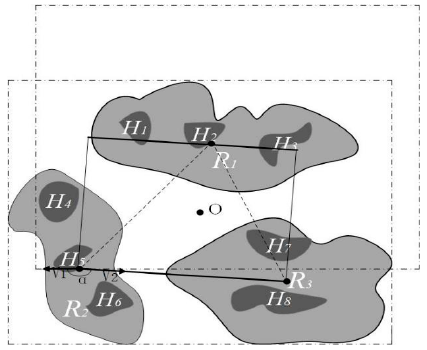
Figure 5. Rotation of CPPG.